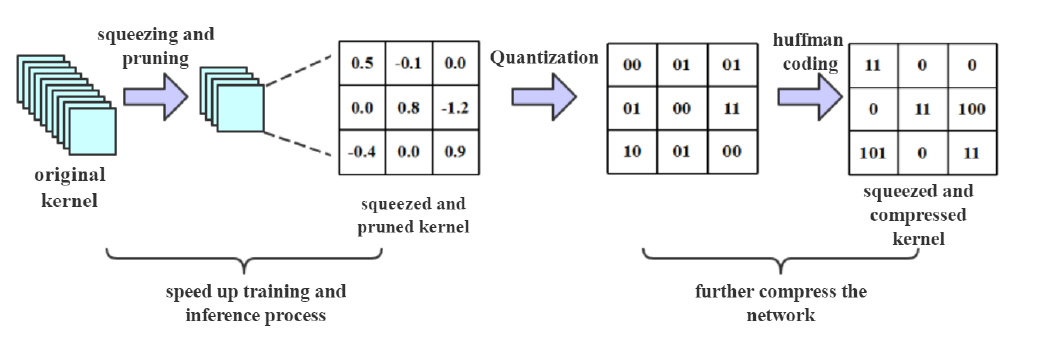
Figure 1. The two state compression and acceleration